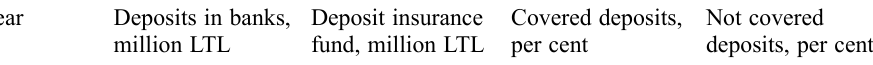
Table 2. The deposits in the banks of the Baltic States and the amounts in deposit insurance funds from 2005 to 2009